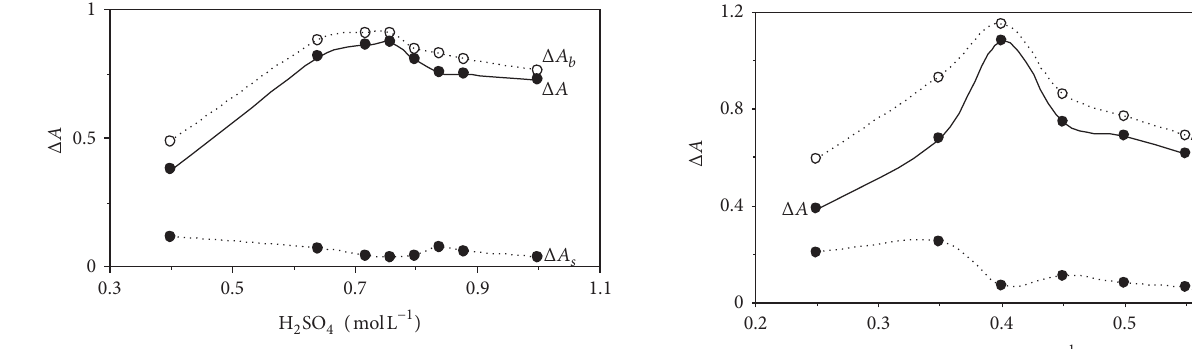
F 2: Effect of sulfuric acid concentration on the rate of uninhibited (